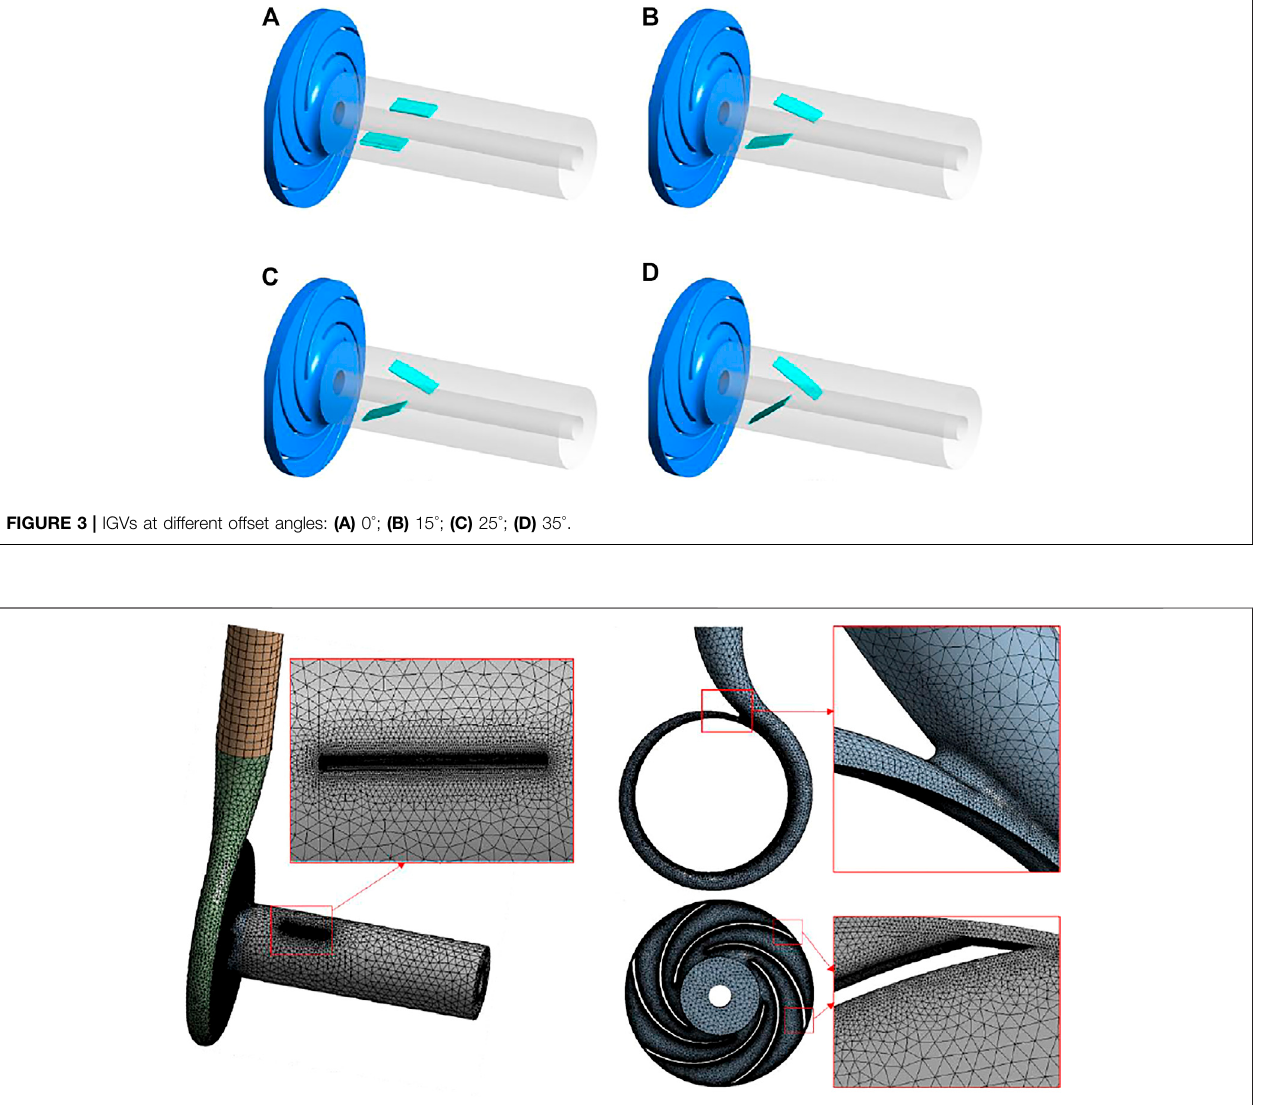
FIGURE 4 | Mesh of IGVs, volute, and impeller.